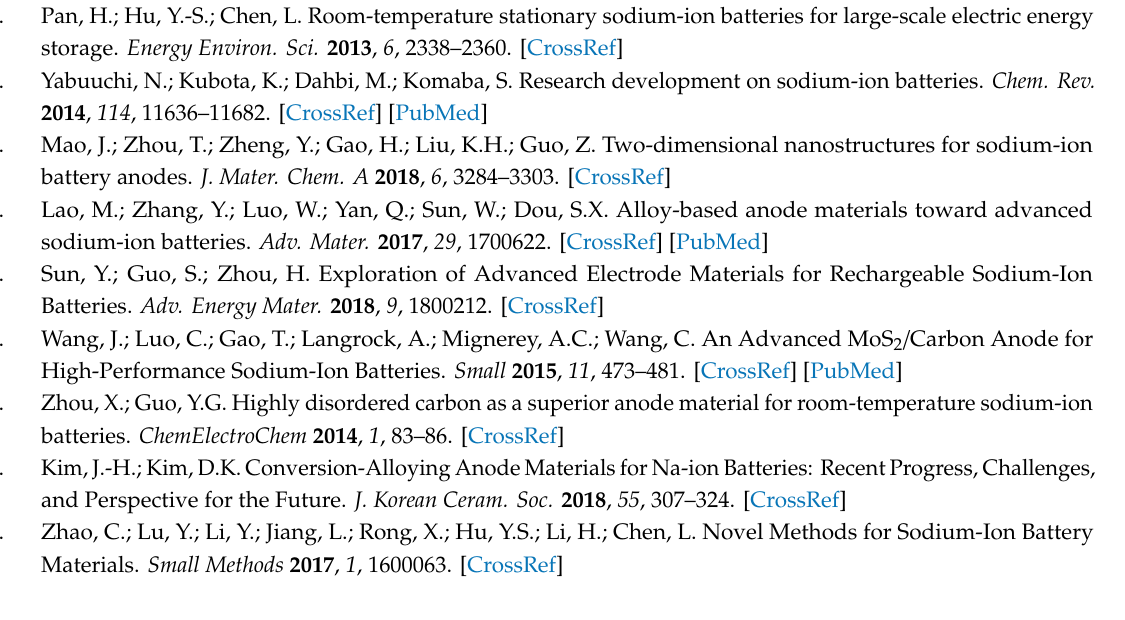
Figure S1: SEM images of the SbTe-C30 electrode prepared with (a) the PVDF binder and (e) the PAA binder. Sb, Te, and C EDS maps corresponding to: (b)–(d) panel a, and (f)–(h) panel e, Figure S2: SEM images of the SbTe-C40 electrode prepared with (a) the PVDF binder and (e) the PAA binder. Sb, Te, and C EDS maps corresponding to: (b)–(d) panel a, and (f)–(h) panel e, Table S1: Electrochemical data of SbTe-C20 electrodes, Table S2: Electrochemical data of SbTe-C30 electrodes, Table S3: Electrochemical data of SbTe-C40